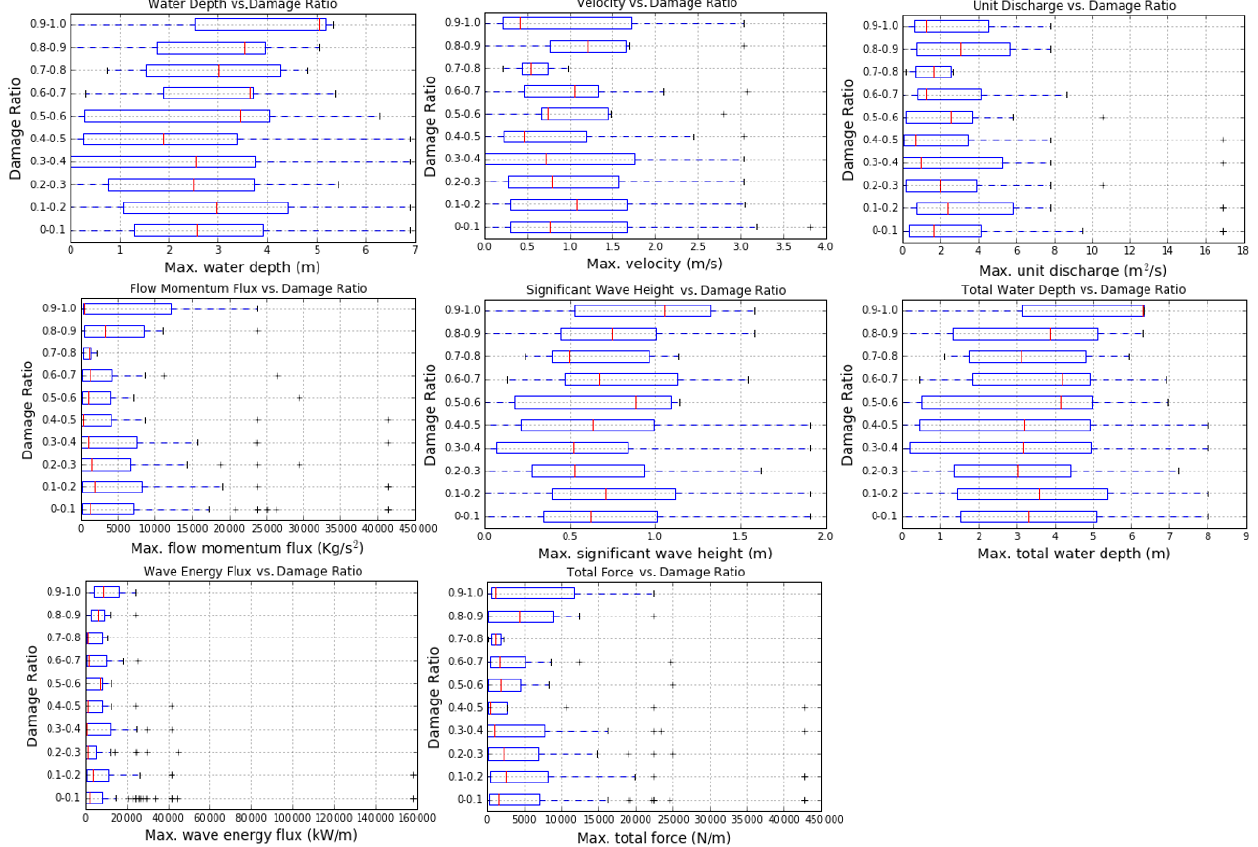
+ ρhv 2 ) with the GEBCO C g